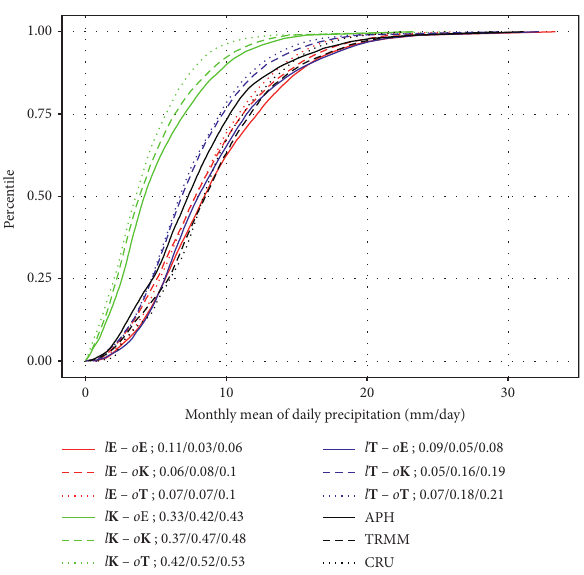
Figure 4: Empirical cumulative distribution function (ECDF) for monthly mean of daily precipitation (mm/day) derived from multiple observations and model simulations. The values next to the name of each experiment are the Kolmogorov–Smirnov (KS) distance versus APHRODITE/TRMM/CRU.